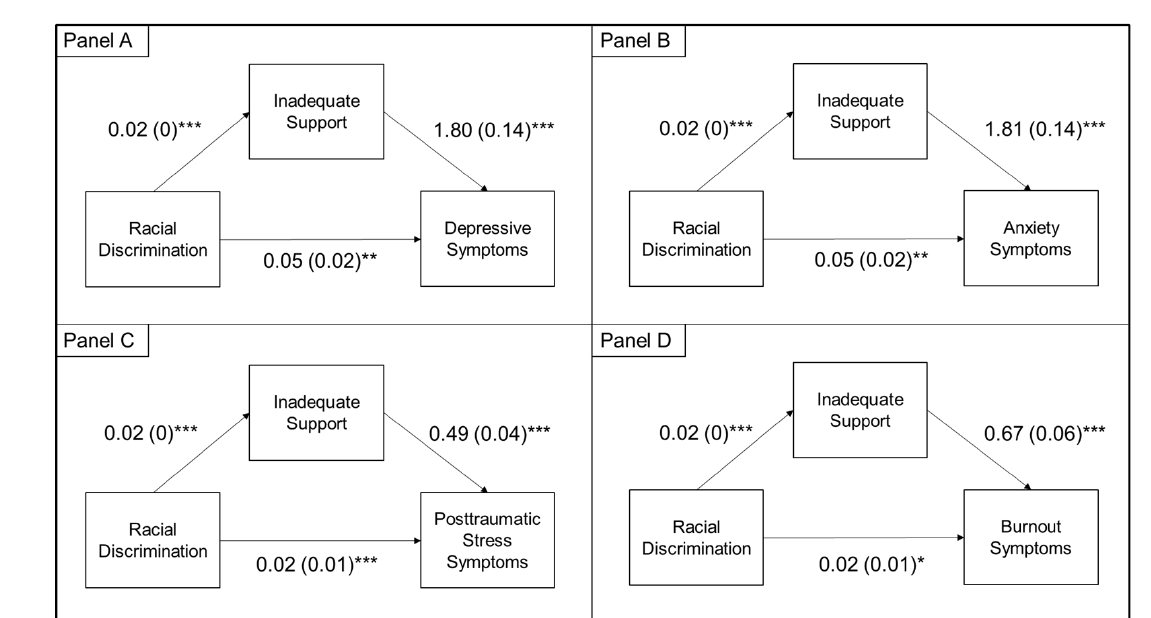
Figure 1. Indirect effects of racial discrimination on symptoms of depression (Panel A ), anxiety (Panel B ), posttraumatic stress (Panel C ), and burnout (Panel D ) via inadequate social support. The indirect effects analysis controlled for age, gender, race/ethnicity, marital status, profession, pre-pandemic mental health diagnosis, income, family/friend being diagnosed with COVID-19, childcare needs, housing change, frontline status, change in roles, change in work hours, and gender discrimination. * p < .05 and ≥ .01; ** p < .01 and ≥ .001; *** p < .001.